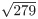
Solé evolutionary networks.The network on the left was generated with δ = 0.25 and α = 0.005. Its has order 279 and has 47 nodes with degrees exceeding 279 and so qualify as hubs. The largest few of these hubs have degrees {40, 41, 62, 80}. This algorithm creates dense networks as seen here, even for small values of α. Increasing the value of δ gives more extended networks. The network on the right was generated with δ = 0.75 and α = 0.005 and grown to order 230. None of its nodes qualify as hubs. The arrangement of nodes and bonds in these networks was created using the prefuse force directed lay-out in Cytoscape 3.4.0 [17].